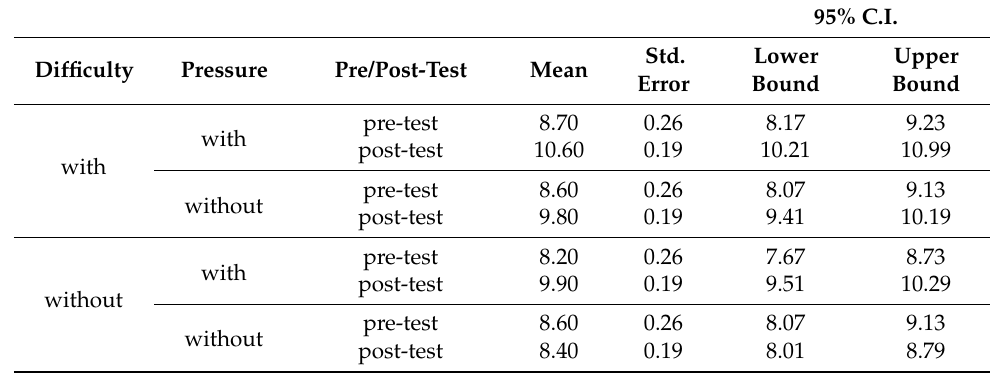
Table 12. Estimated marginal means of SAT- Interaction of difficulty * pressure * pre/post-test.